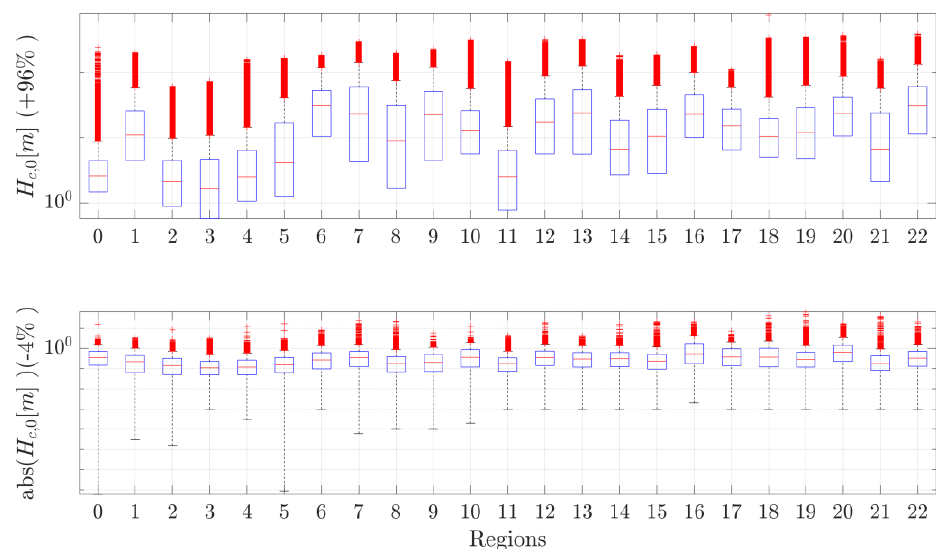
Figure 15. Regional statistics of initial cliff relief 𝐻 𝑐,0 along GB coastline. The central mark indicates the median, and the bottom and top edges of the box indicate the 25th and 75th percentiles, respectively. The whiskers extend to the most extreme data points not considered outliers, and the outliers are plotted individually using the “+” symbol. See Table S1 for correspondence between region number and admin unit used.